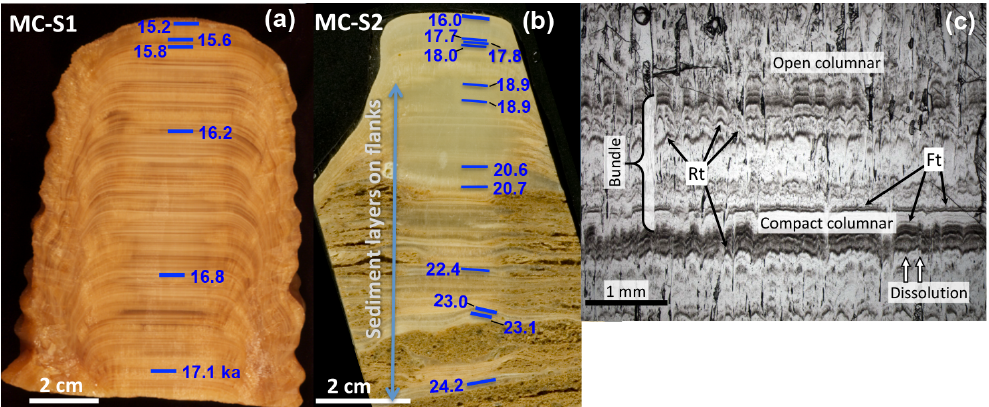
Figure 2. Mairs Cave stalagmites MC-S1 (a) and MC-S2 (b) with age measurements (ka) indicated. Photograph of thin section from MC- S1 showing parallel laminae (c) . See Sect. 4.2 for description of features in thin section. MC-S2 contains layers of sediment interbedded with calcite lenses in its lower half. Sediment continues to be visible on the side flanks until 25mm below the top, coinciding with the age measurement of 18.9ka. White annulus in layer over 20.6ka age measurement is a sectioned